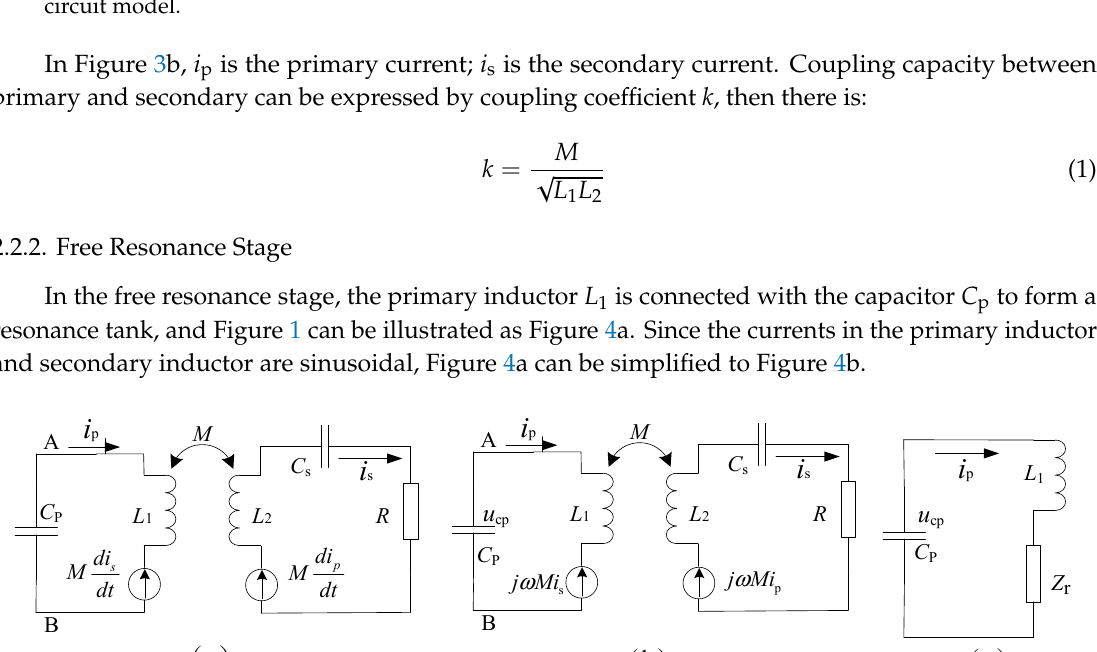
Figure 3. Circuit models in the energy injection stage ( a ) simplified circuit model; ( b ) equivalent circuit model.